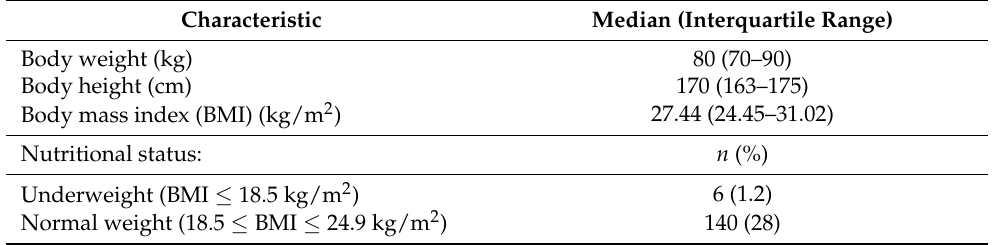
Table 2. Mean body weight, body height, body mass index (BMI), and patient distribution according to nutritional status ( n =